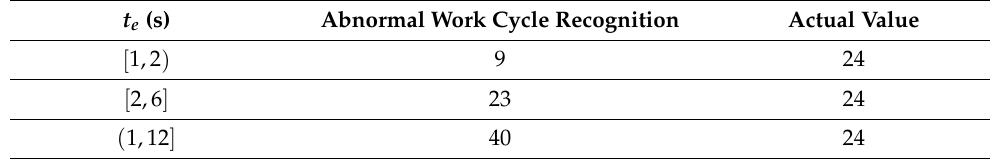
Table 4. Effect of t e -value on abnormal work cycles